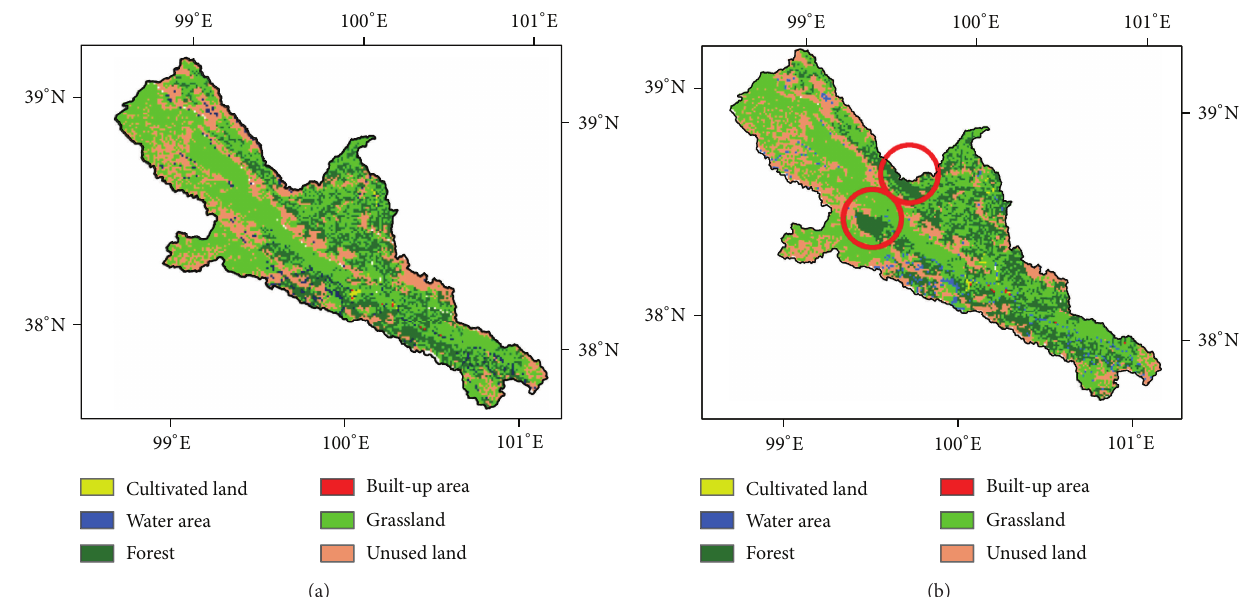
Figure 2: The land use map in the upstream of Heihe River Basin: (a) 1980; (b) scenario based simulated map.